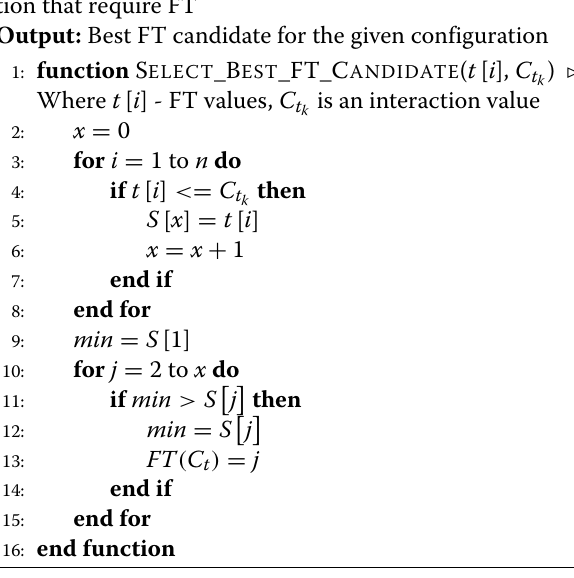
Table 2 Overview of software system considered System Domain Language LOC Configurations